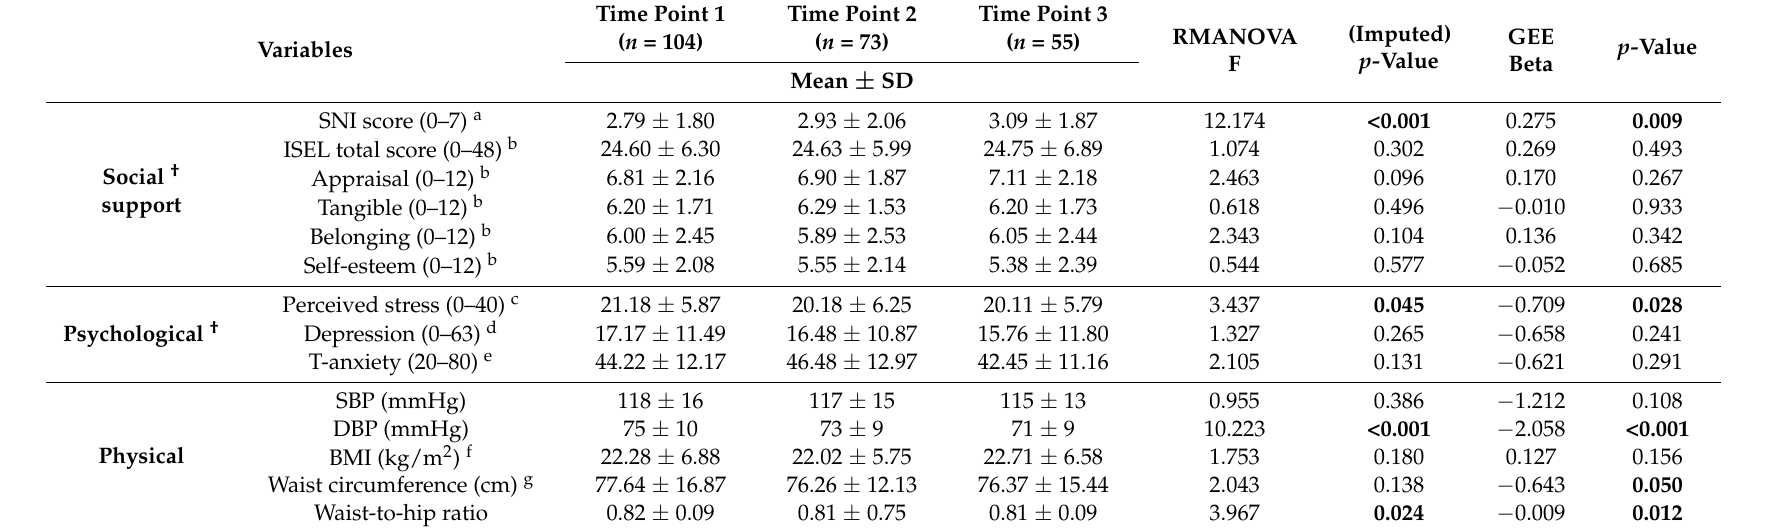
Table 2. The key social, psychological and physical health variables of identified in hikikomori followed up for one